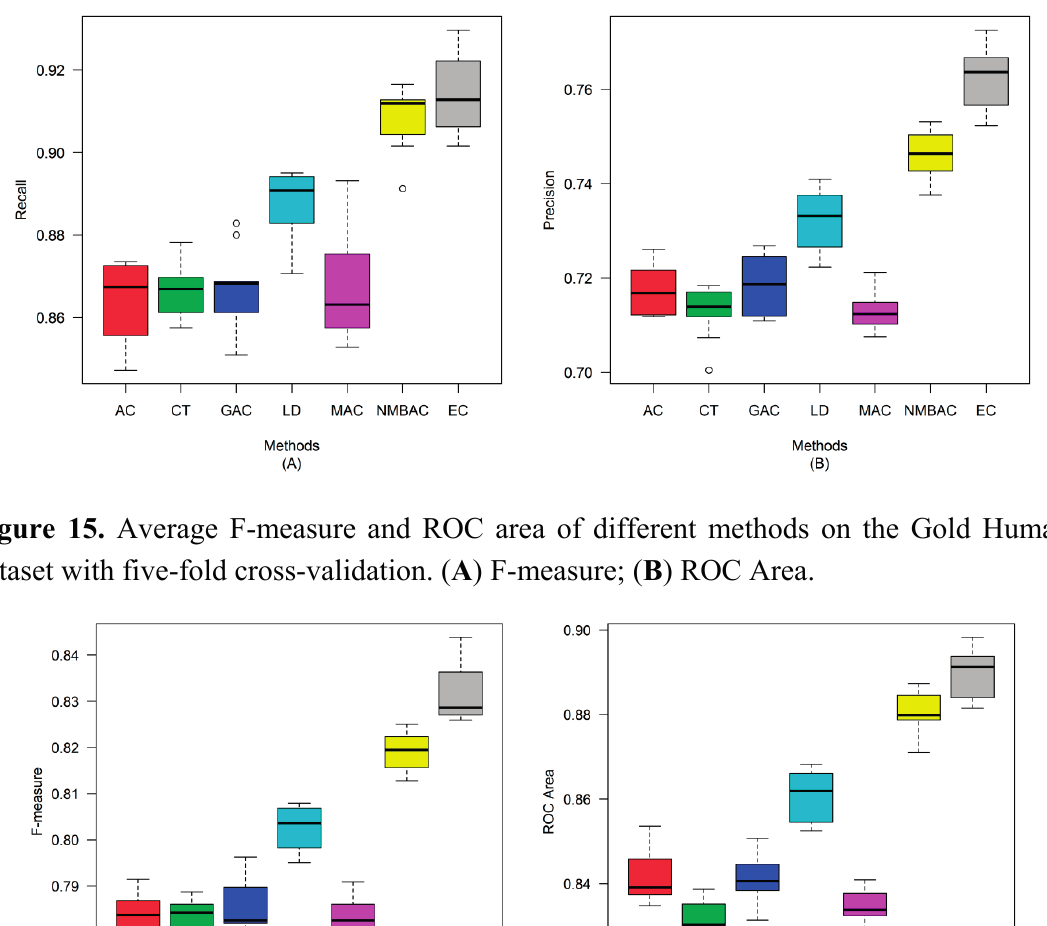
Figure 14. Average recall and precision of different methods on the Gold Human dataset with five-fold cross-validation. ( A ) Recall; ( B ) Precision.